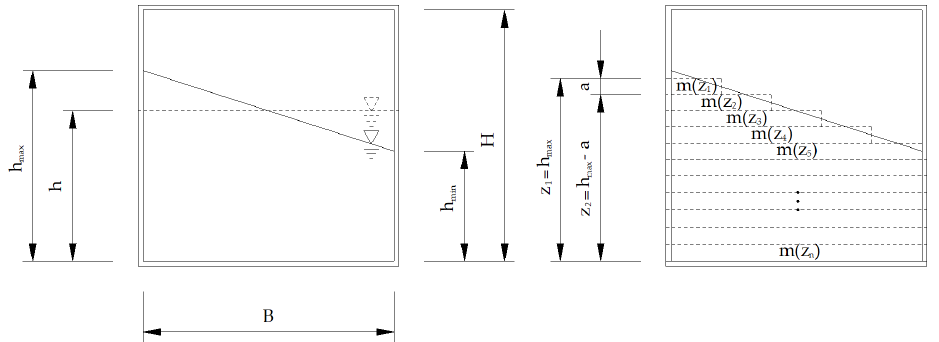
Figure 11. Dynamic pressure distribution of proposed model.